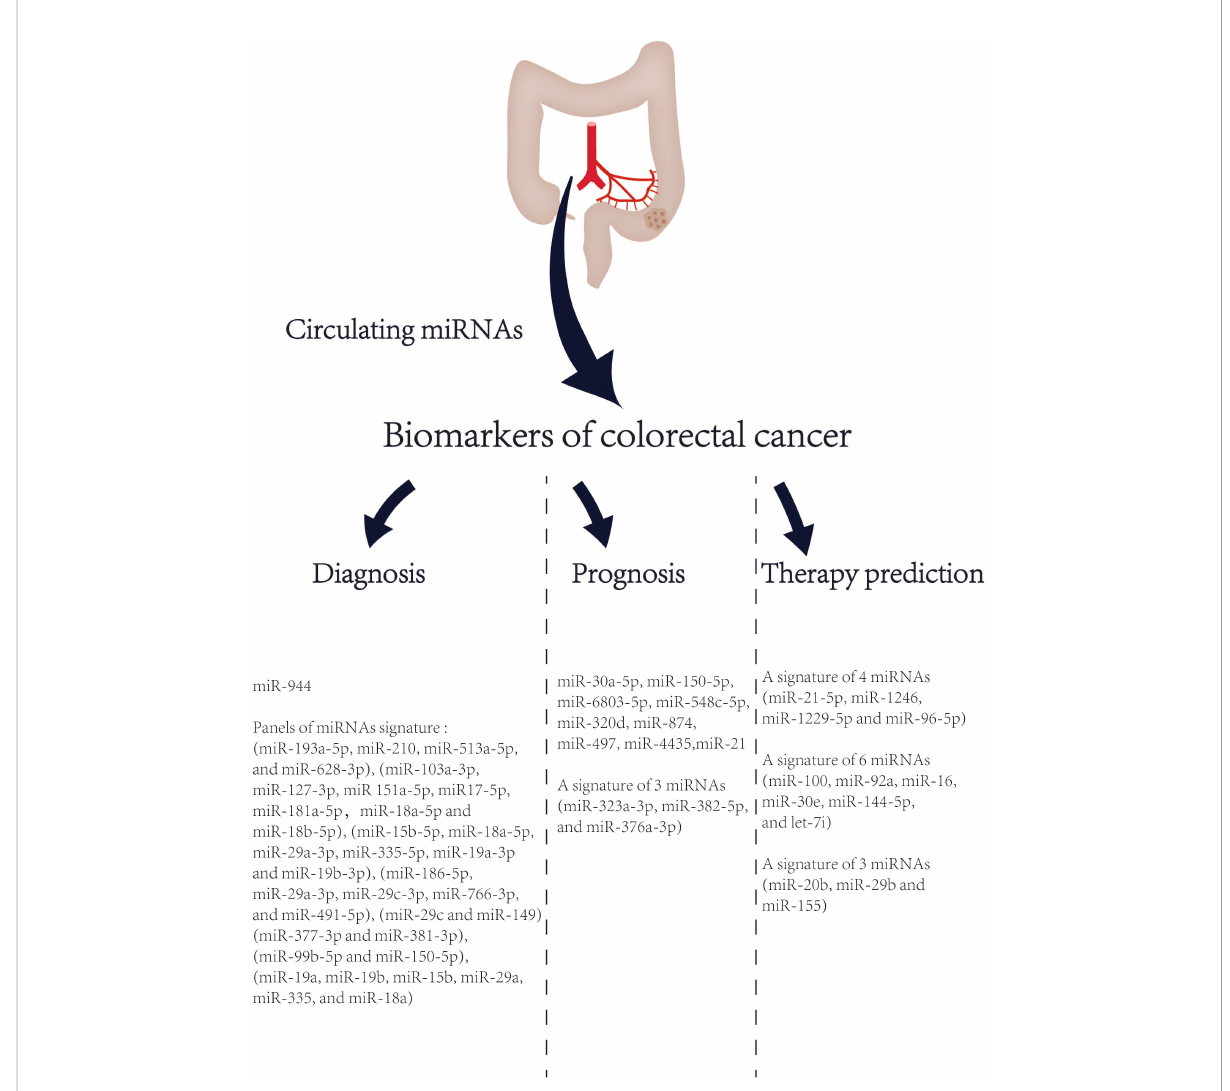
FIGURE 2 List of circulating miRNAs reported as promising biomarkers in CRC in recent 5 years. References are provided in Table